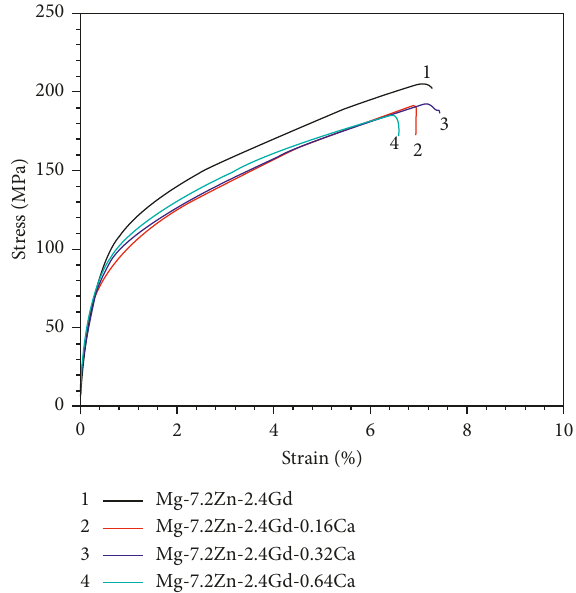
Figure 4: Tensile stress-strain curves of the as-cast Mg-Zn-Gd(-Ca) alloys.